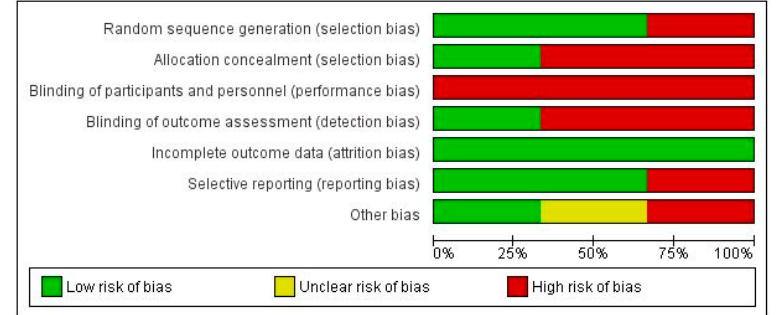
Figure 2. Risk of bias graph.